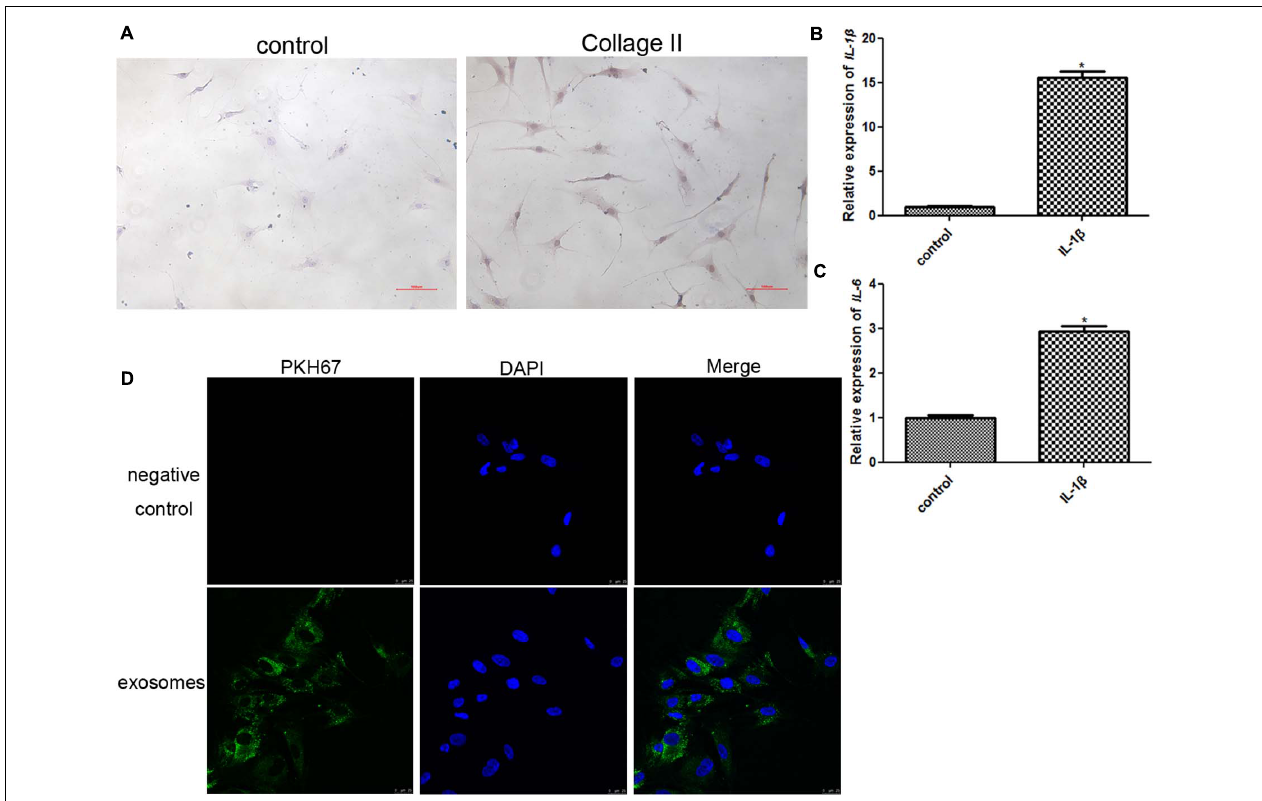
FIGURE 2 | (A) Identification of chondrocytes using immunocytochemical staining of collagen II (100 × ). (B) The expression level of IL-1 β after chondrocytes were induced by IL-1 β . * P < 0.05 vs. control group. n = 3. (C) The expression level of IL-6 after chondrocytes were induced by IL-1 β . * P < 0.05 vs. control group. n = 3. (D) PKH67-labeled exosomes could be taken up by chondrocytes induced by IL-1 β after co-culture.